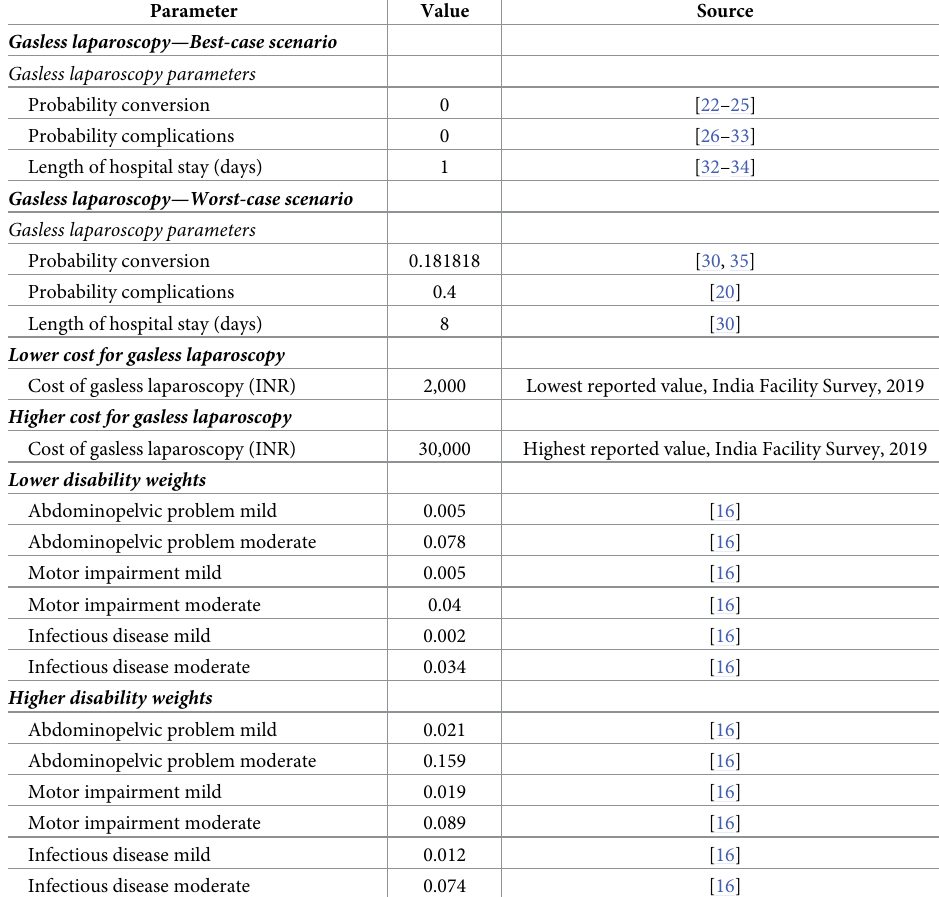
Table 2. Parameter values—Sensitivity